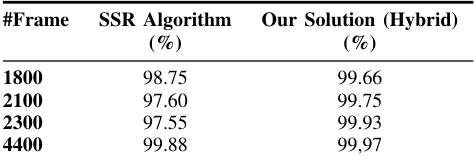
TABLE II I MAGE QUALITY RESULTS OF FOUR DIFFERENT FRAMES FROM THE WALKTHROUGH SEQUENCE , IN TERMS OF REFLECTIONS , COMPARED TO THE IDEAL CORRESPONDING IMAGES GENERATED BY THE RAY TRACING , WITH THE SIMPLIFIED GEOMETRIC VERSION OF THE Sponza SCENE AND THE TWO DEFORMABLE MESHES OF THE T- REX DINOSAURS